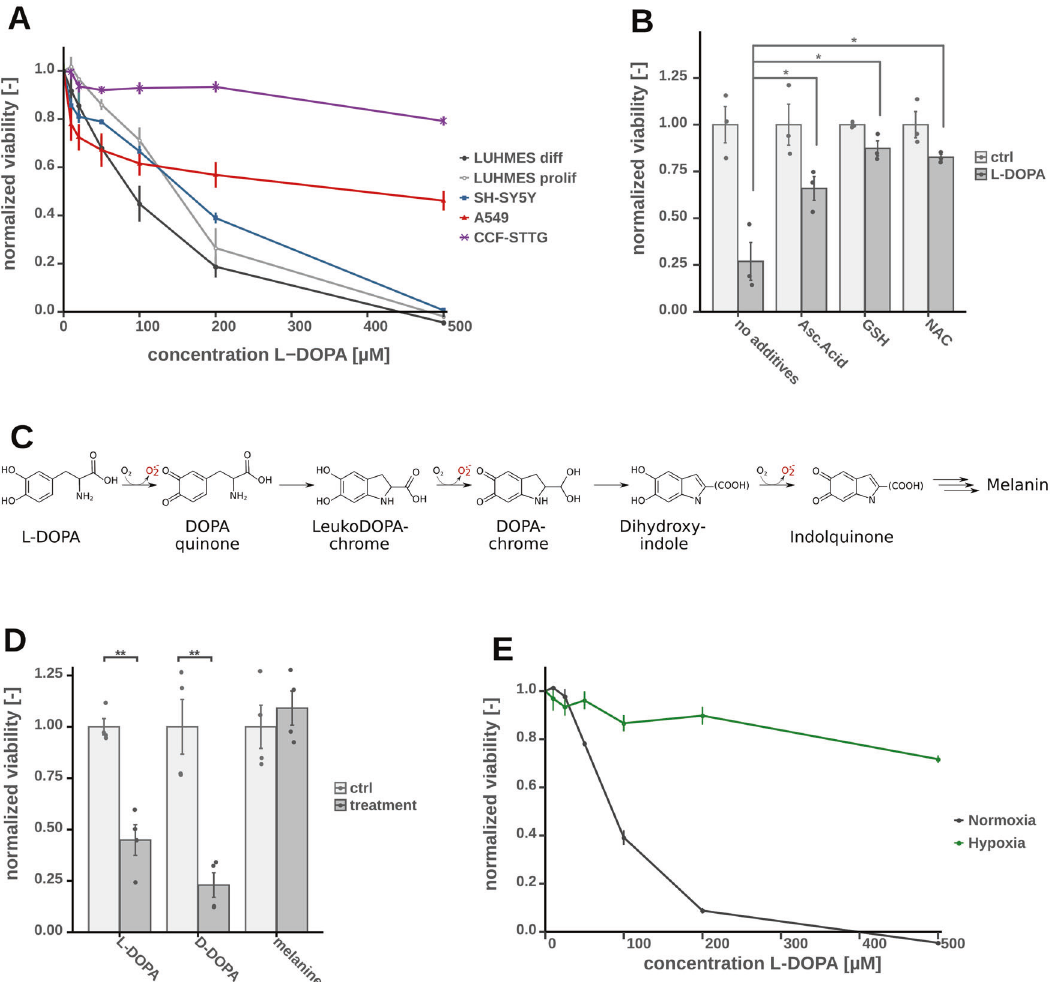
Fig. 1 Viability assay based on resazurine after 24 h of L -DOPA treatment of LUHMES, displayed with the means and standard errors and normalized to the control group without L -DOPA, signi fi cance level were calculated using Welch ’ s t -test (* p -value < 0.05, ** p -value < 0.01). A Viability of additional cell types treated with varying L -DOPA concentrations including fully differentiated (diff) LUHMES as well as proliferating (prolif) LUHMES ( n = 4). B Co-incubation of with different anti-oxidant reagents GSH (1 mM), NAC (1 mM) or ascorbic acid (500 µM) together with 100 µM L -DOPA ( n = 3). C Overview of the auto-oxidation process of L -DOPA including ROS formation. D Comparison of toxicity of L -DOPA (200 µM), D -DOPA (200 µM), and melanin formed from 200 µM L -DOPA solution ( n = 3), E Comparison of cytotoxic effect of L -DOPA under normoxic and hypoxic conditions ( n =